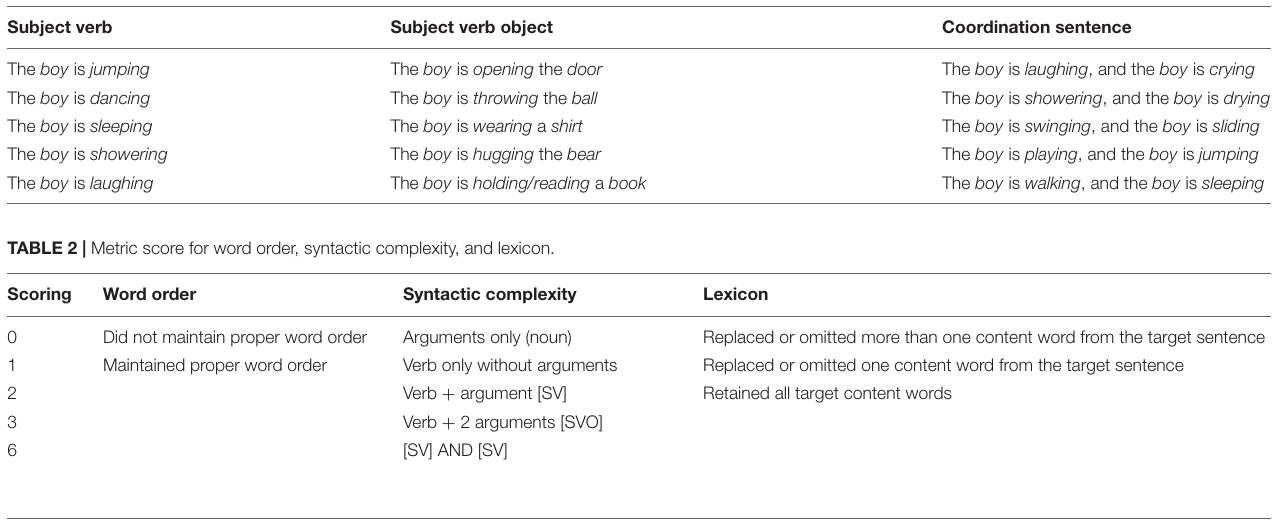
TABLE 1 | Target constructions (SV, SVO, and Coordination Clauses).